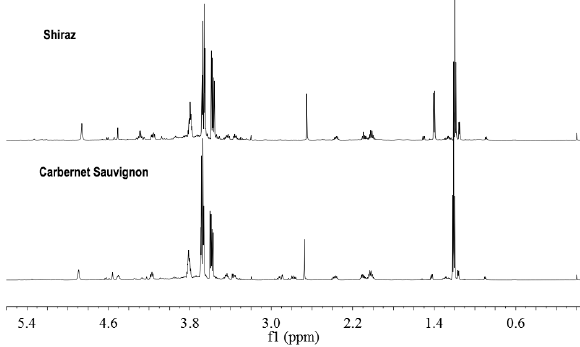
Figure 1: 1 H NMR spectrum of Cabernet Sauvignon and Shiraz dry red